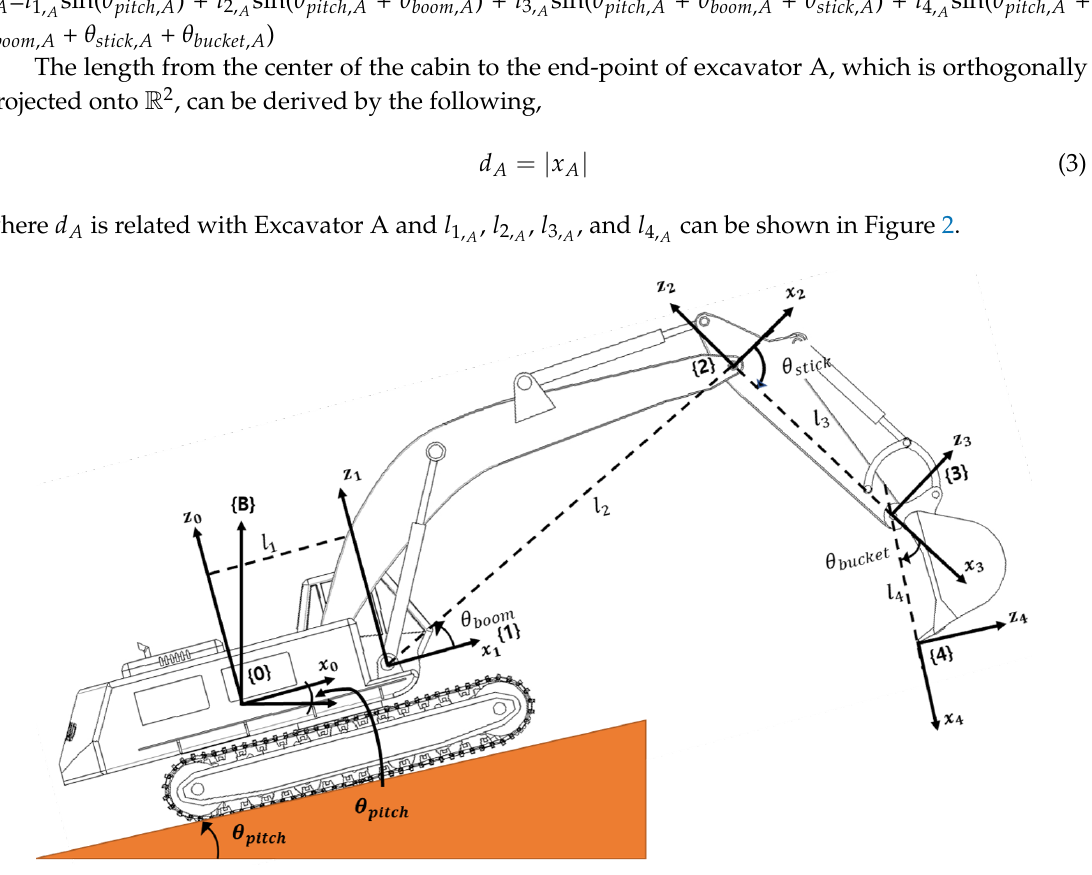
Figure 2. The excavator on a slope with kinematic parameters and